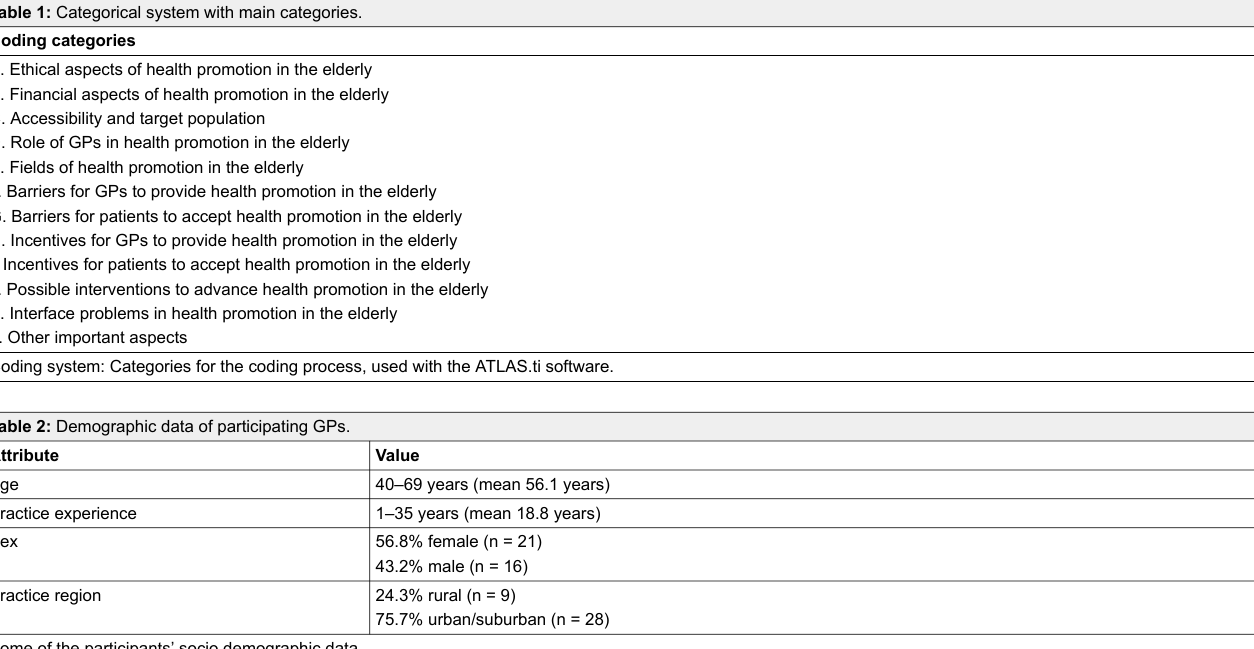
Table 1: Categorical system with main categories. Coding categories